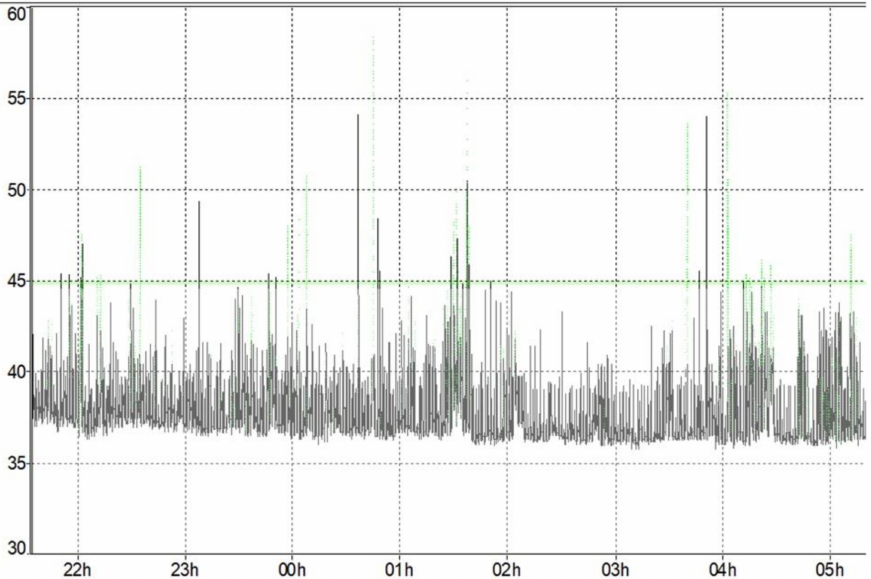
Figure 8. Time history of the first night (in green, the threshold exceedances set to L Aeq = 45 dB(A)).